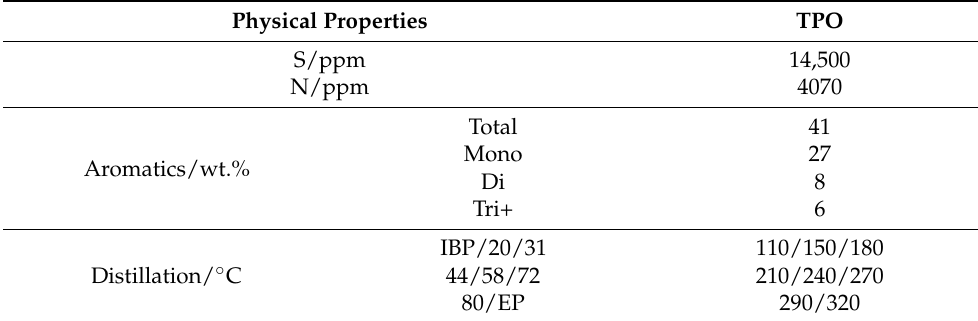
Table 2. Composition and properties of tire pyrolysis oil (TPO) .